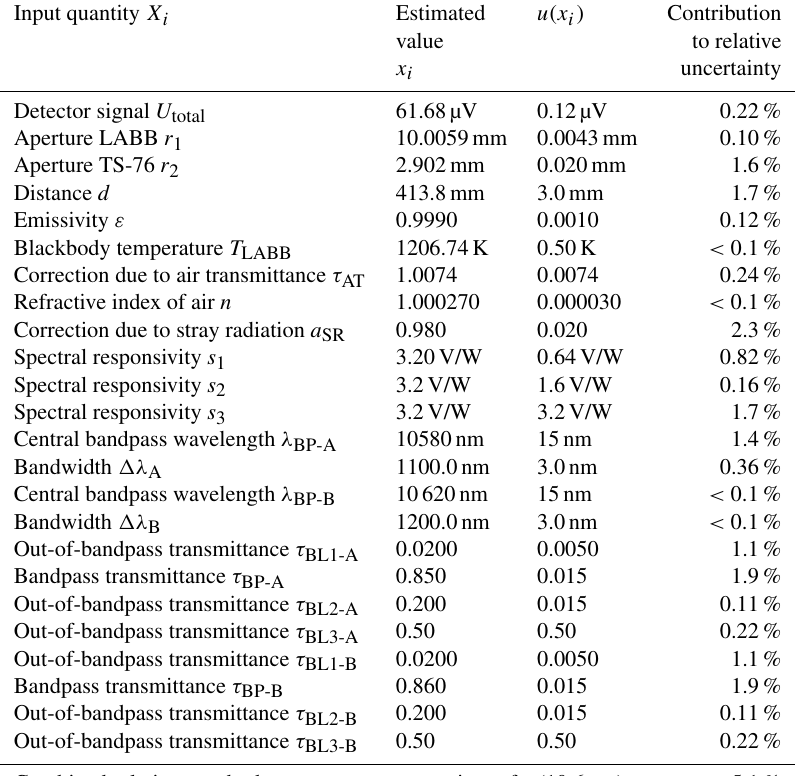
Table 1. List of all input quantities X i , their estimated values x i and standard uncertainties u ( x i ) as well as their contributions towards the combined relative standard measurement uncertainty of the spectral responsivity of the thermopile detector TS-76 for the calibration at the blackbody radiator LABB with filters with a central bandpass wavelengths of about 10.6µm. The values of the quantities for the filter model that is used for the calculation of the uncertainty are based on the measurement results of the Fourier transform spectrometer and former calibration